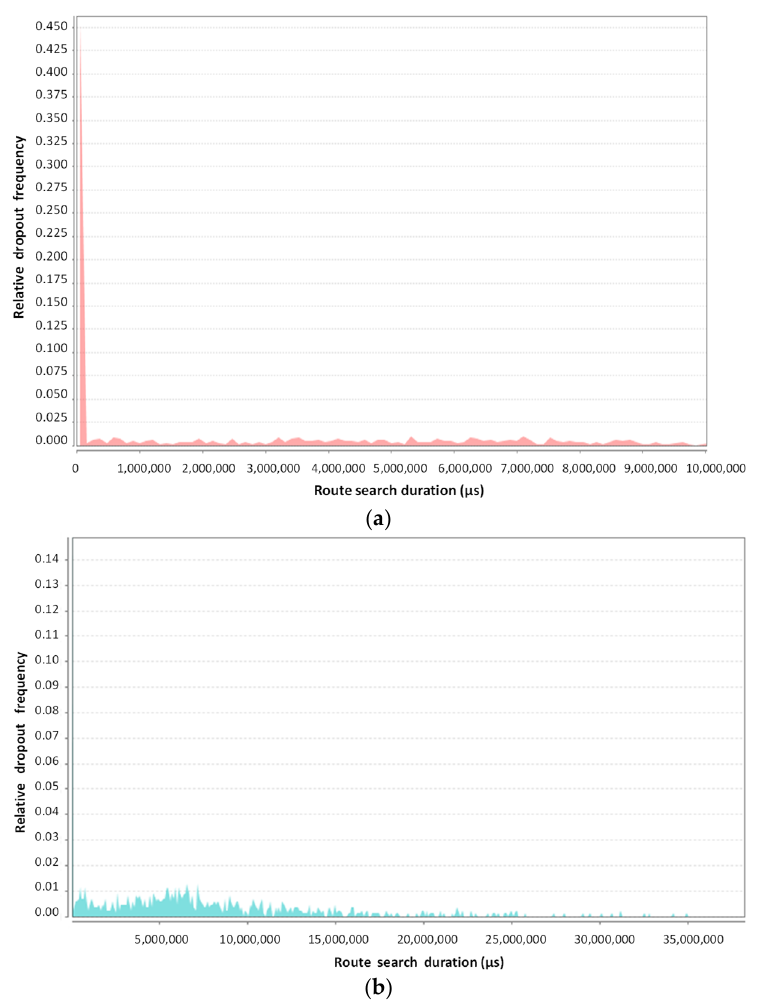
Figure 16. The duration of route search with different values of SNR: ( a ) 90 dBm; ( b ) 77